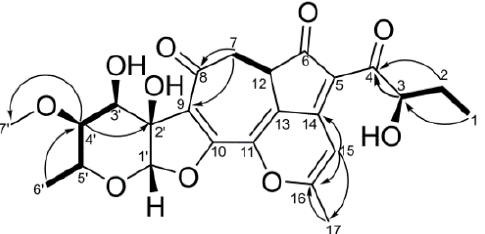
Figure 2. Key COSY and HMBC correlations for 7,12-dihydroisatropolone C (H 2 ITC, 1ab ). Table 1. NMR data of 7,12-dihydroisatropolone C ( 1ab ) and isatropolone C in acetone- d 6 . 7,12-Dihydroisatropolone C (1ab) Isatropolone